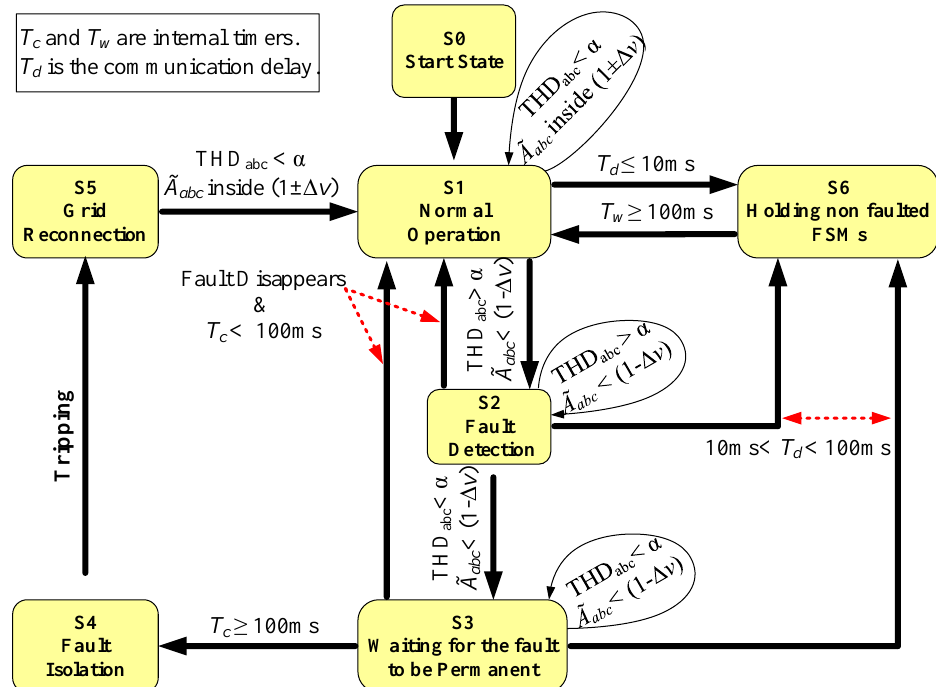
Figure 4. Scheme of the proposed FSM.